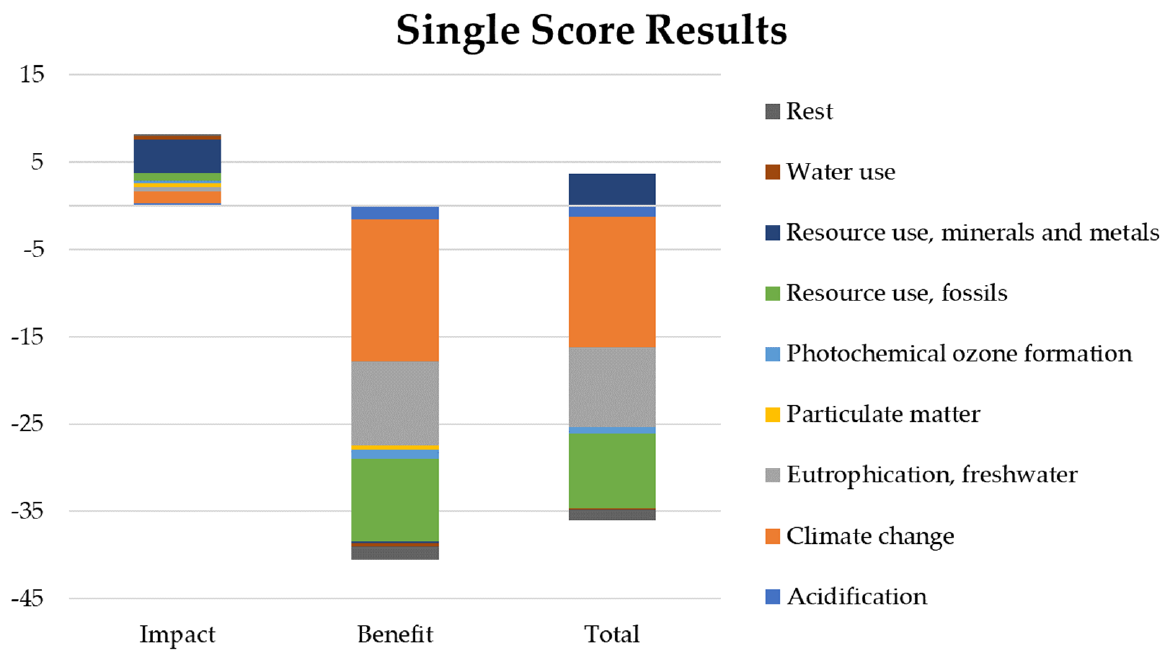
Figure 2. Environmental impact of the change of 1 ha single-use agriculture to an AVS in Germany presented as single score results per year.